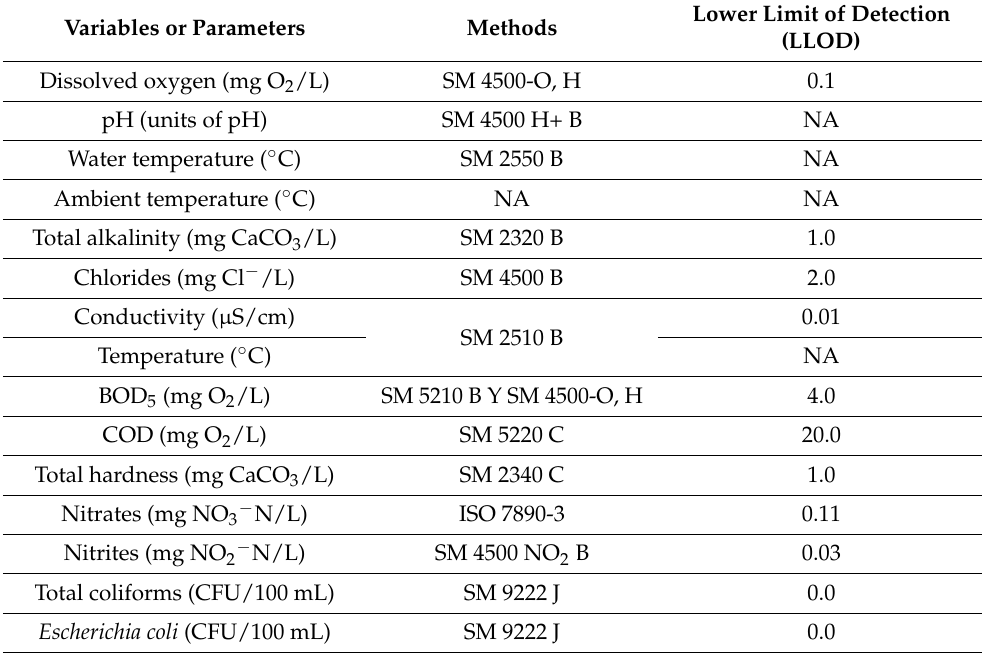
Table 1. Physico-chemical and microbiological methods conducted for groundwater samples analyses. Variables or